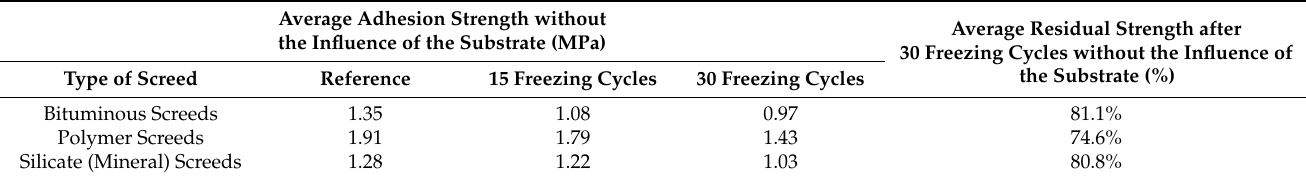
Table 4. Total adhesion strength and total residual strength after 30 freezing cycles. Average Adhesion Strength without the Influence of the Substrate (MPa)